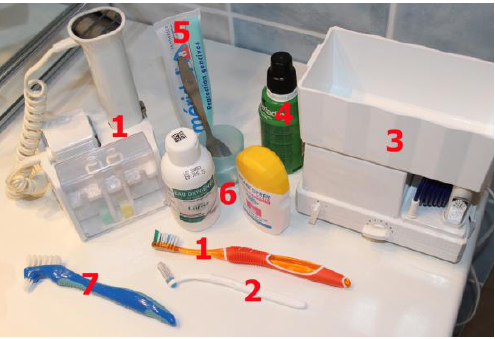
Figure 4. Oral hygiene devices: seven devices for optimal domiciliary hygiene procedures. The most important are: 1, Sonic brush with vertical movement; manual toothbrush; 2. interdental brushes; and 3, oral irrigators.